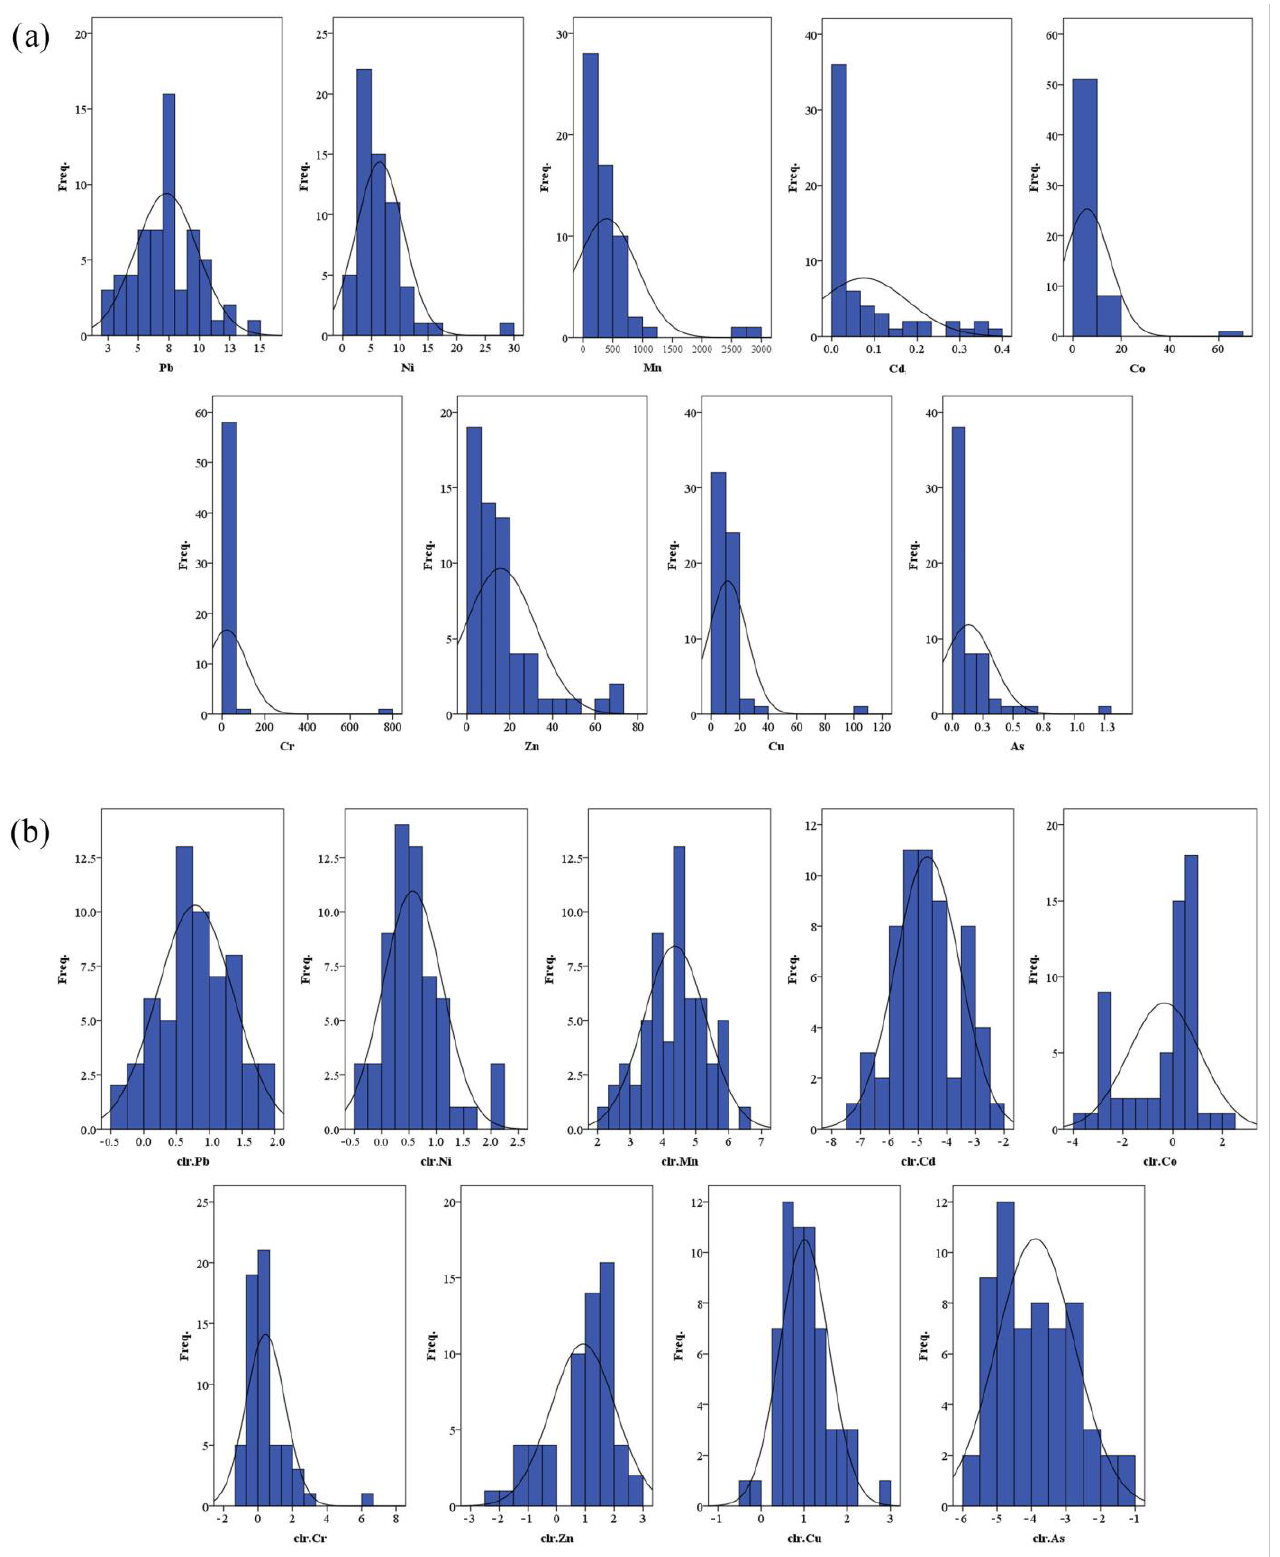
Figure 4. PTE histograms for raw data ( a ) and clr-transformed data ( b ).